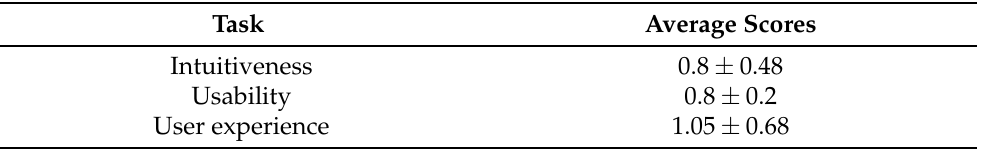
Table 11. Average scores of user